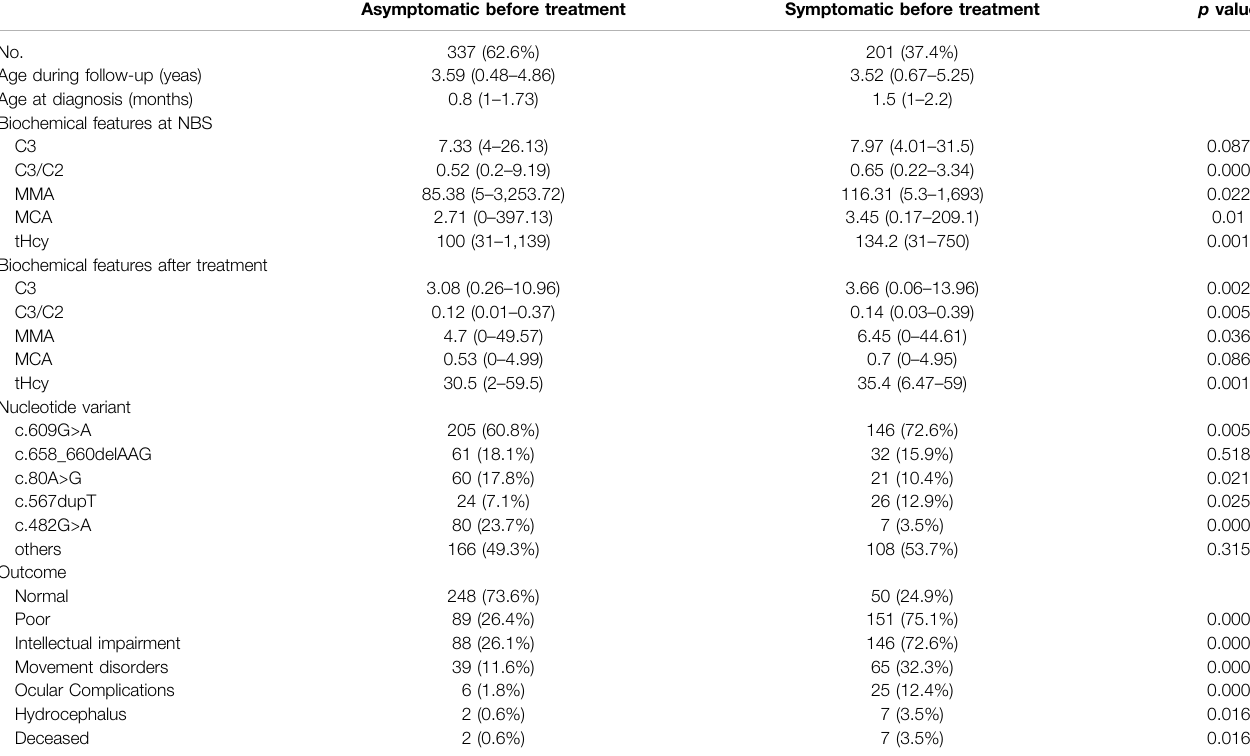
TABLE 2 | Comparison of baseline demographic, clinical, and biochemical characteristics between patients with or without symptoms before treatment. Asymptomatic before treatment Symptomatic before